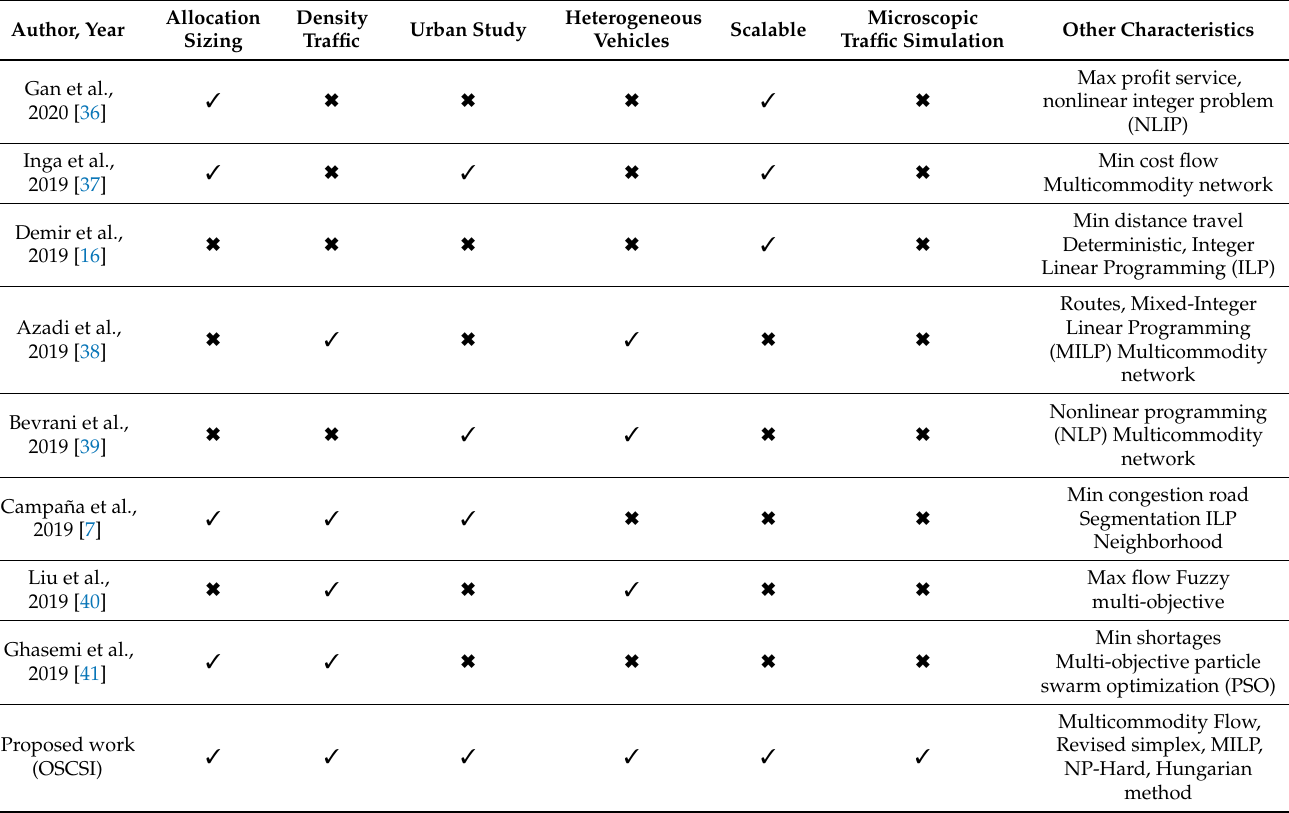
Table 2. Summary: comparison of the results with other